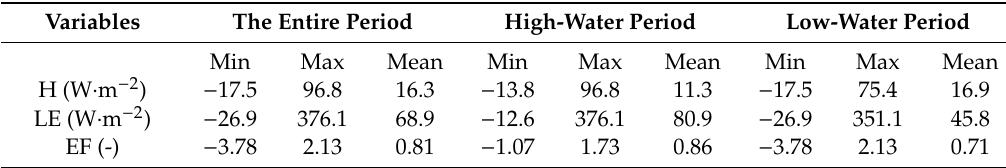
Figure 4. Seasonal variations in H, LE, and EF in 2015. The outliers of EF when H + LE was close to 0 are not shown in the figure. Table 1. Statistics of daily H, LE, and EF.